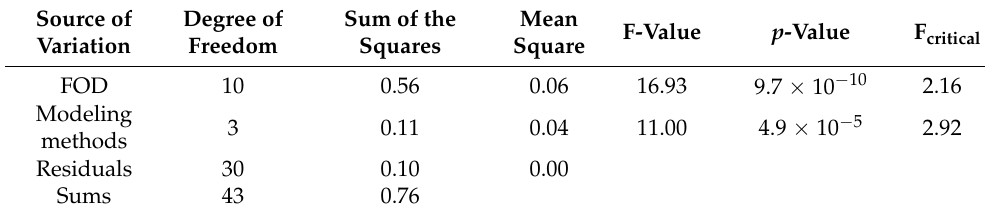
Table 10. Analyses of variance with the RMSE values for